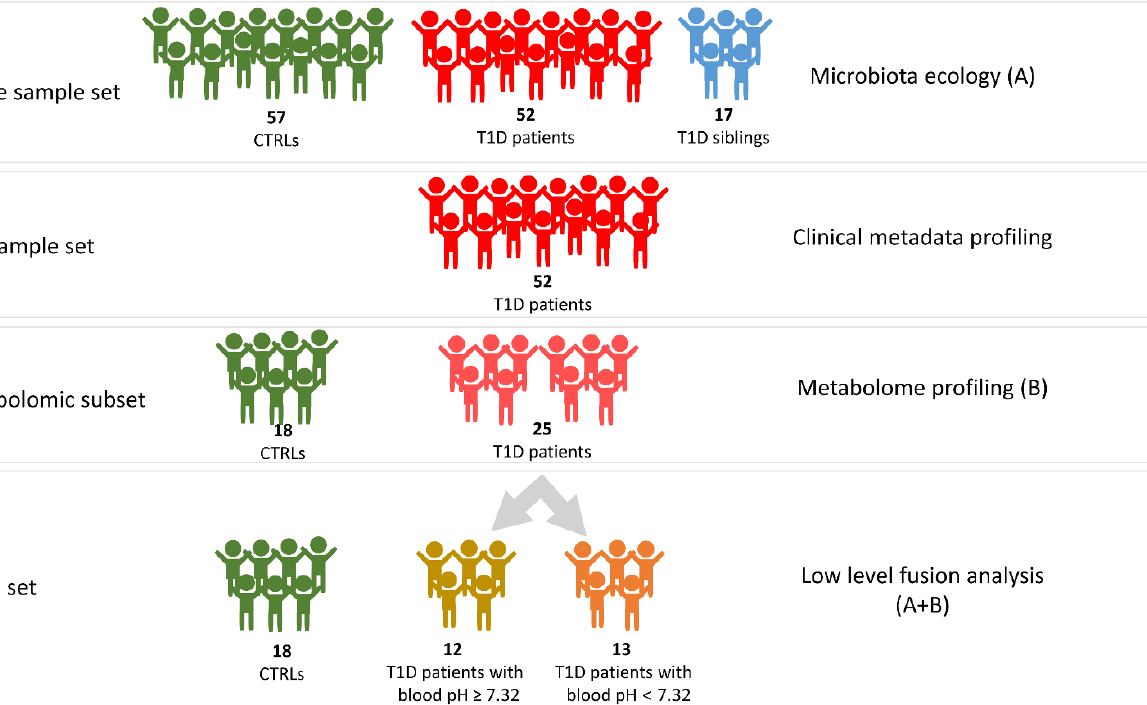
Figure 6. Graphic representation of the workflow of omics analyses. A, microbiota ecology outcome; B, metabolome profiling outcome. A + B, integration of metabolomic and metagenomic results.